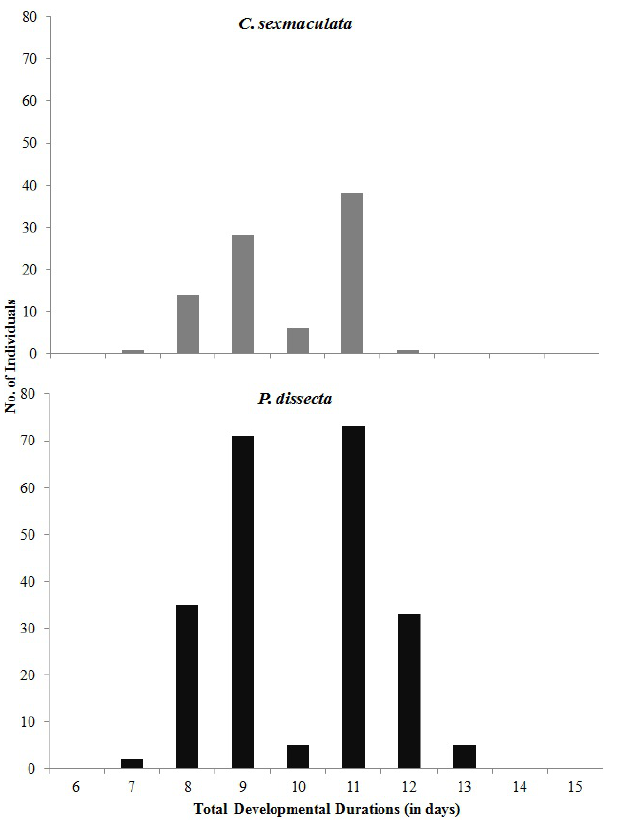
Figure 1. Frequency distribution of total developmental durations in ladybirds, C. sexmaculata and P. dissecta